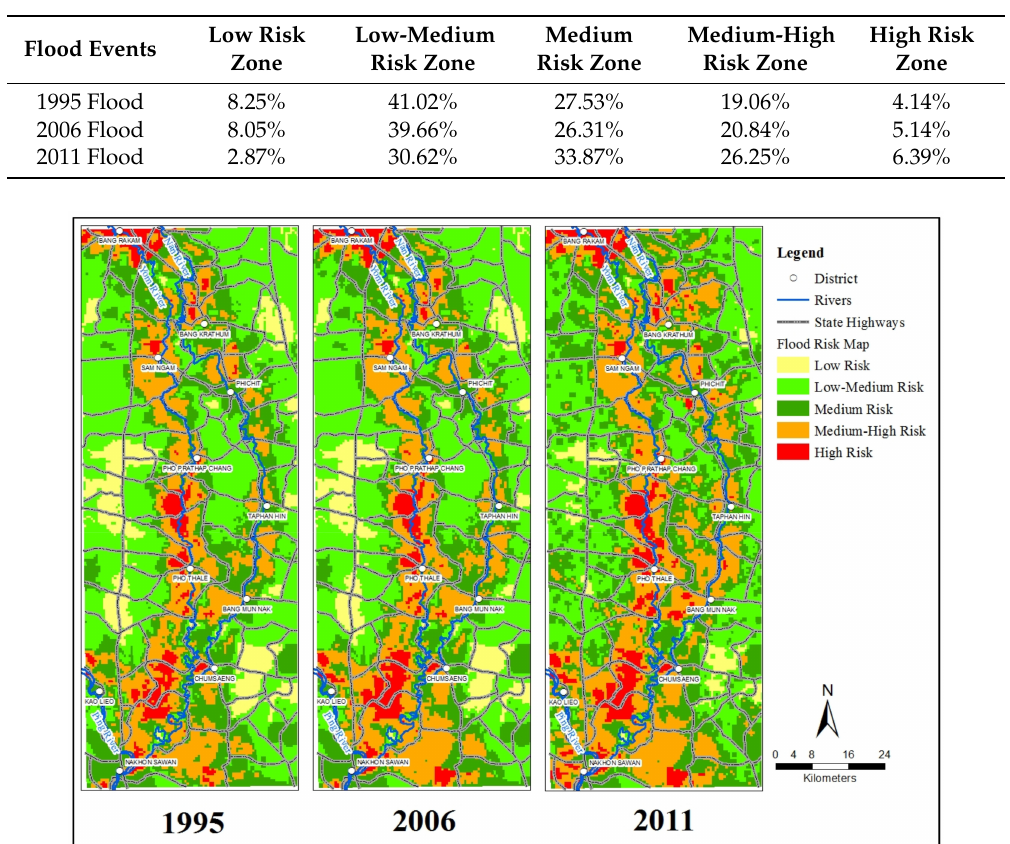
Figure 5. Flood risk maps for low-lying areas in the middle CPRB in 1995, 2006 and